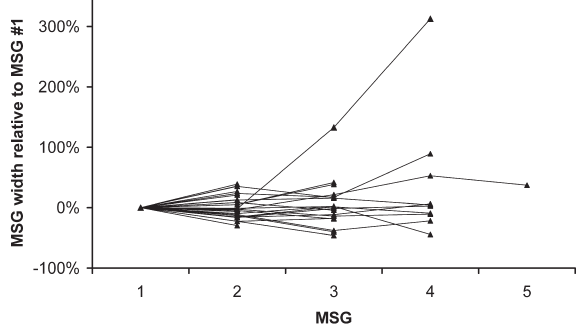
Fig . 3. – Change of width of marks of skeletal growth (MSG) in 28 individual turtles with at least two observed MSGs, expressed as change (%) from the most internal MSG (#1).